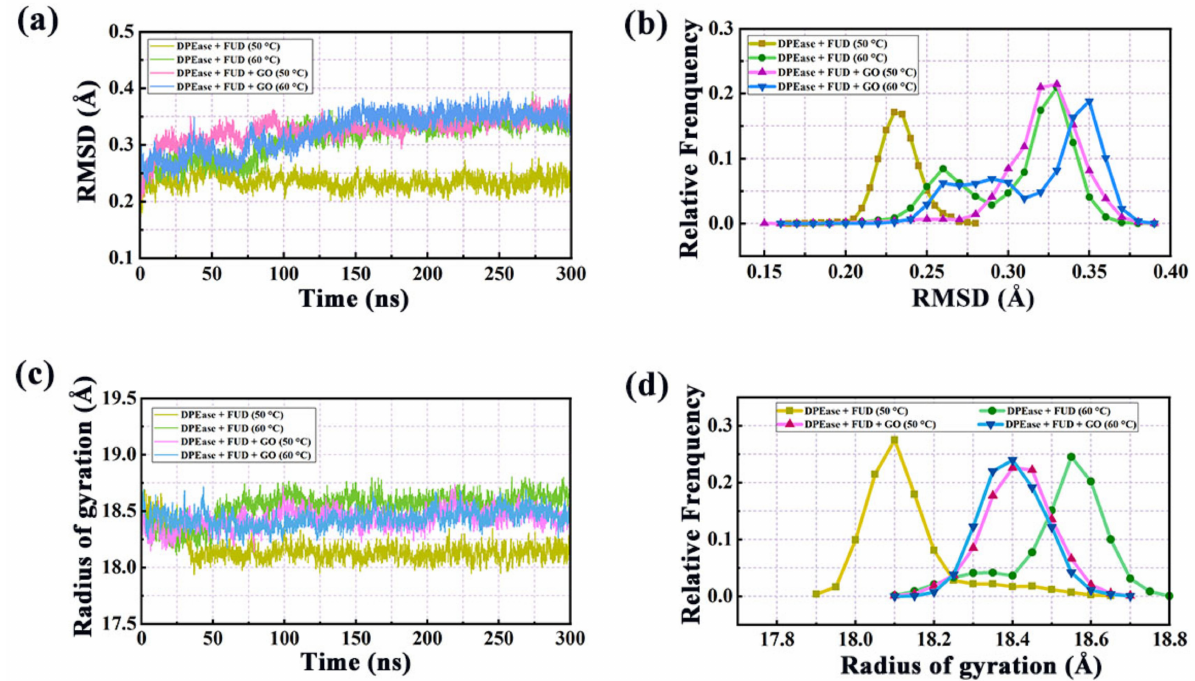
Figure 2. ( a ) Time evolution of RMSDs for backbone atoms in four systems throughout the 300 ns MD simulations; ( b ) corresponding frequency for RMSD; ( c ) radius of gyration changes in four systems during simulations; ( d ) relative frequency for radius of